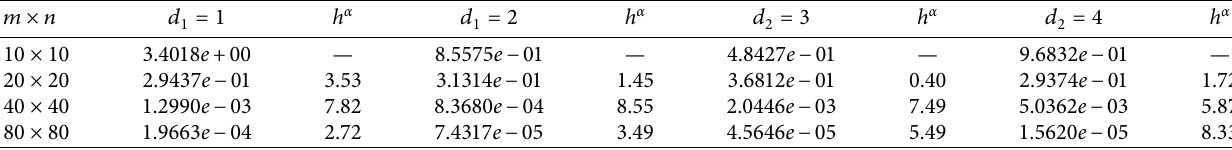
� 4 ,d � 4 ) . 1 2 � 9 for Example 2. 2